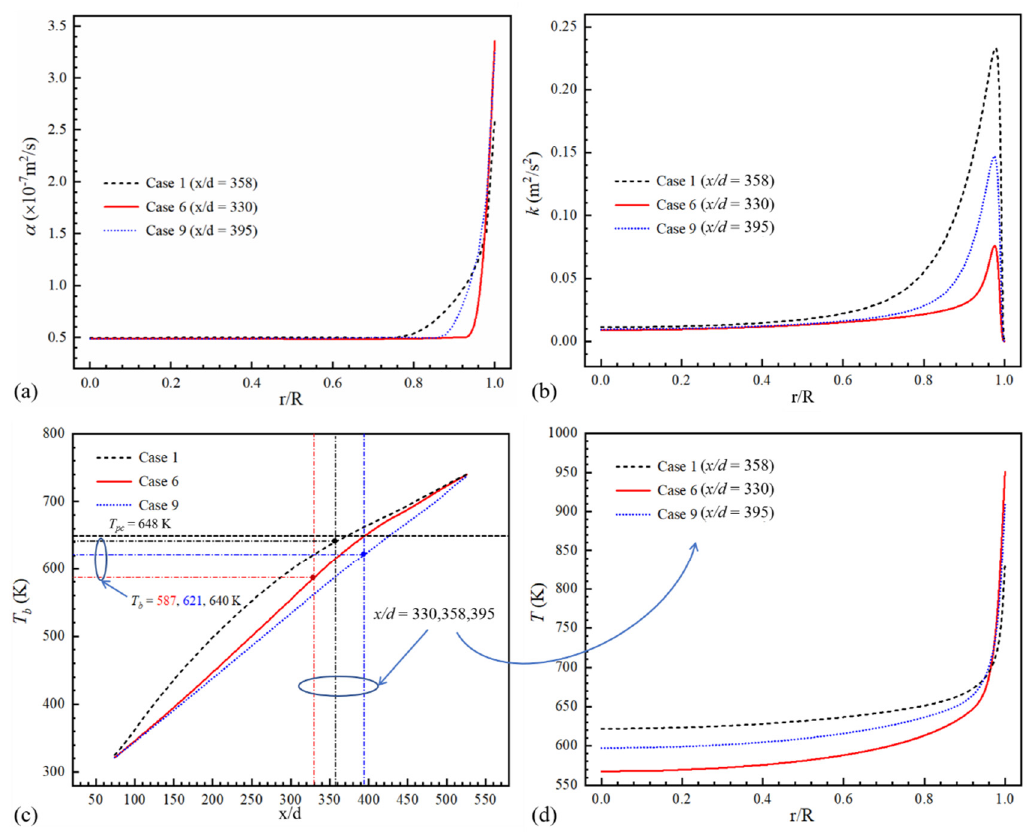
Figure 18. Comparison of flow and thermal characteristic at the initial position of the second HTD in three cases: ( a ) thermal diffusion coefficient; ( b ) turbulent kinetic energy; ( c ) bulk fluid temperature; ( d ) temperature profile.